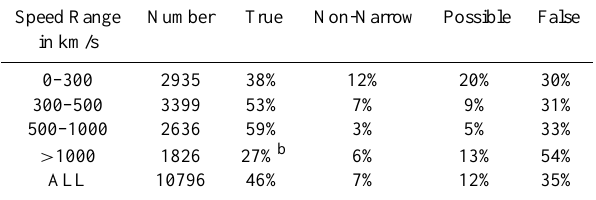
Table 1. Narrow CACTus CMEs a .